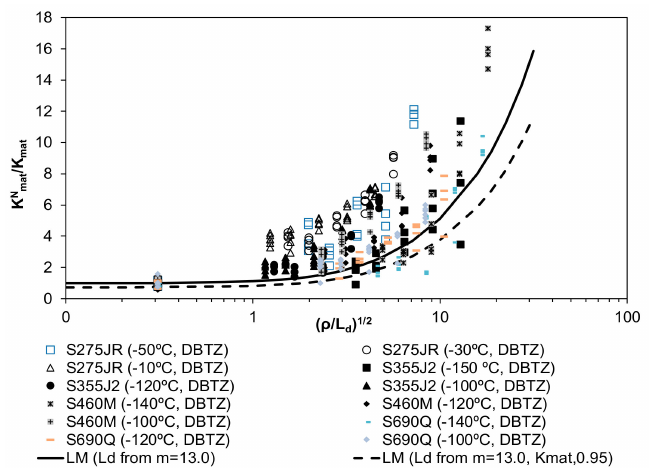
Figure 7. Apparent fracture toughness predictions ( m = 13.0) and comparison with the experimental results. Structural steels operating at the